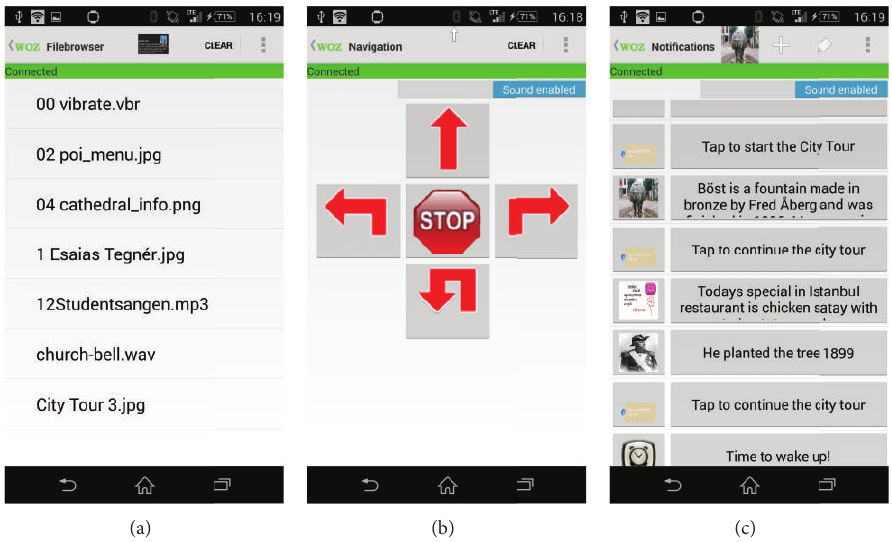
Figure 2: The wizard device UI: (a) list of playable multimedia, (b) navigation, and (c) notifications.